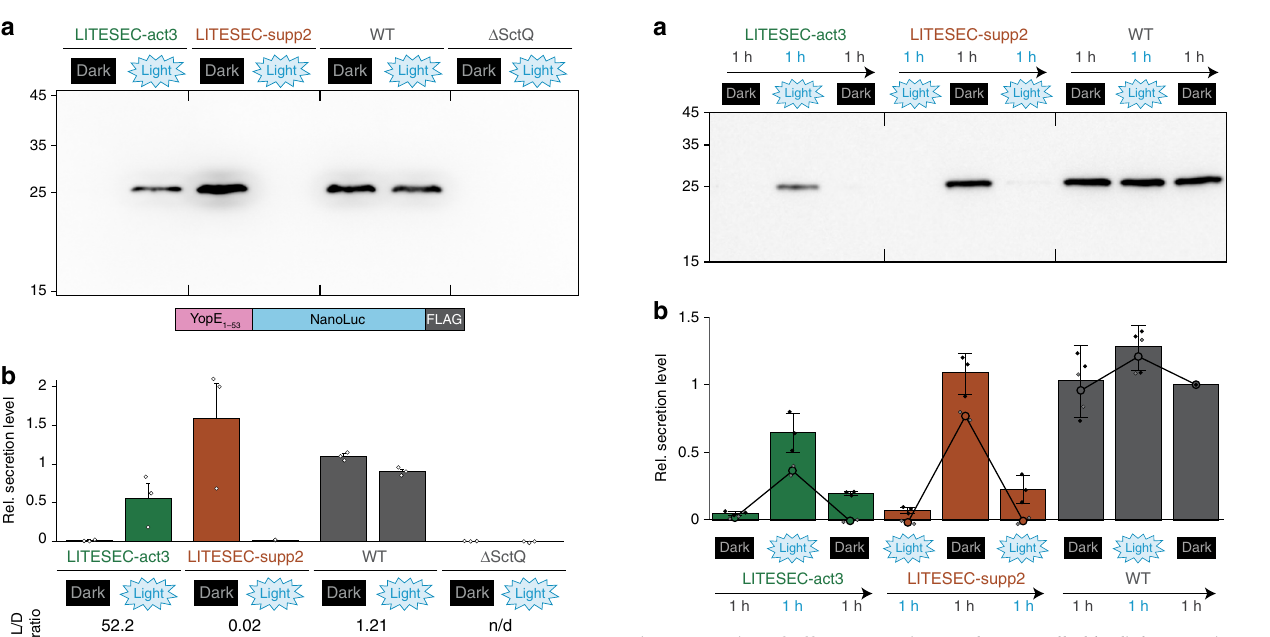
Fig. 7 Secretion of effector proteins can be controlled by light over time. a Export of the heterologous substrate YopE 1-53 -NanoLuc-FLAG in the indicated strains. Secretion-competent bacteria were subsequently incubated under inactivating, activating and inactivating light conditions for 60 min each, as indicated, and the supernatant of 3 × 10 8 bacteria was analyzed. Left side, molecular weight in kDa. b Quanti fi cation of the relative export ef fi ciency (normalized to the wild-type level in the third incubation period) of the strains and conditions shown ( a ) for export of YopE 1-53 - NanoLuc-FLAG as determined by chemiluminescence (bars; N = 3 densitometry values from independent experiments, single data points shown as black dots) and immunoblot (circles, continuous line; N = 2, single data points shown as gray points); bars show mean values; error bars denote standard deviation. Values for a negative control ( Δ SctQ expressing YopE 1-53 -NanoLuc-FLAG) were too small to display in the NanoLuc chemiluminescence assay (<0.001 for all time points). Source data are provided as a Source Data visible reaction of host cells to incubation with T3SS-inactive bacteria, even after extended incubation times (Supplementary Fig. 10), indicating little T3SS-independent effects of bacteria on the used eukaryotic cells. Taken together, these results con fi rm that translocation of heterologous proteins into eukaryotic host cells by the T3SS can be controlled by external light.